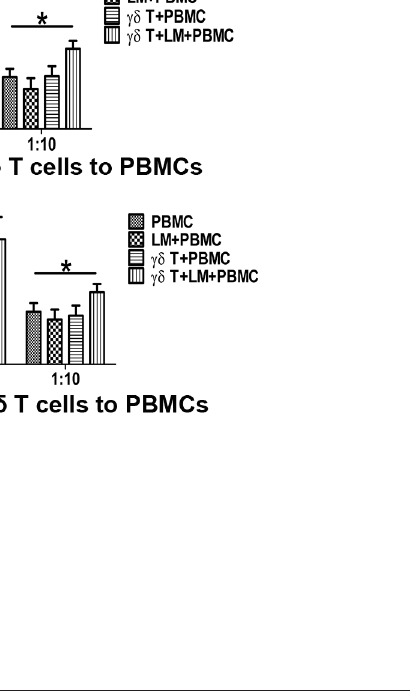
Figure 5. Phagocytized L. monocytogenes , activated γδ T cells to induce CD4 cell and CD8 T cell proliferation. (A) PBMC, PBMC plus L. monocytogenes , PBMC plus γδ T cells or PBMC plus γδ T cells infected by L. monocytogenes were cultured for six days then the